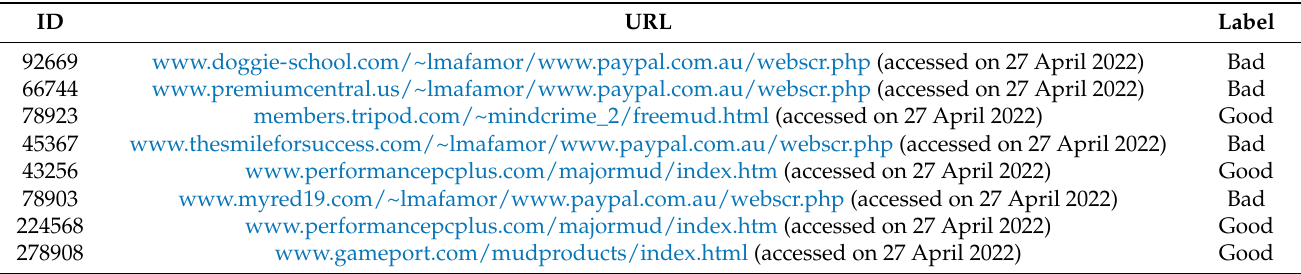
Table 2. Dataset sample